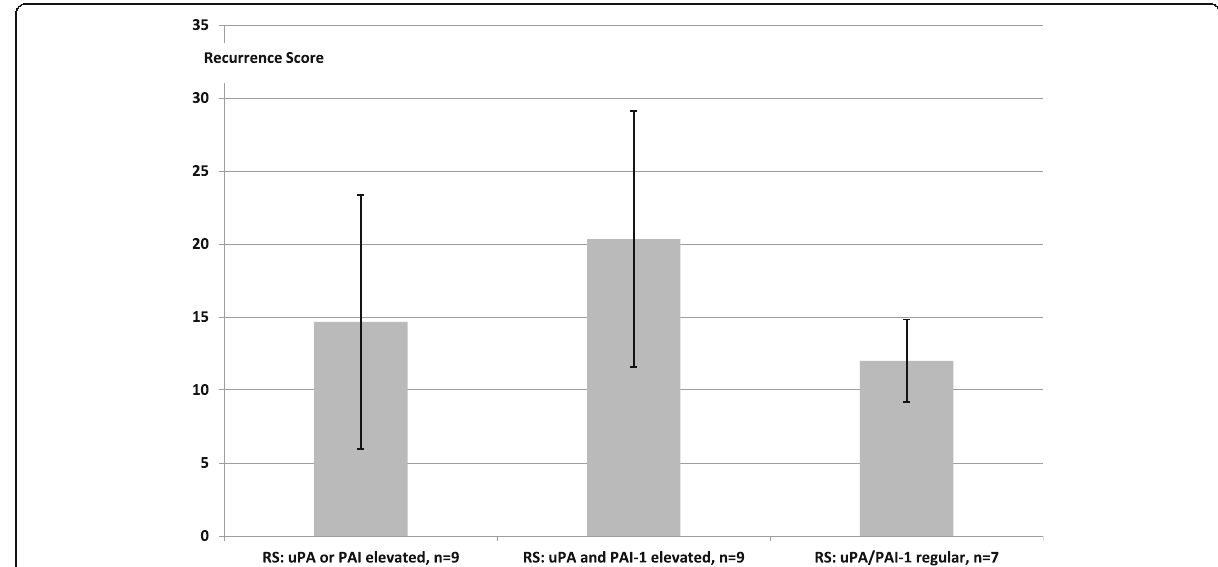
Fig. 3 Recurrence score (RS) from OncotypeDX® in elevated uPA or PAI-1, both uPA and PAI-1, and regular values of uPA/PAI-1. The diagram shows the average values, but the median values were on the same level